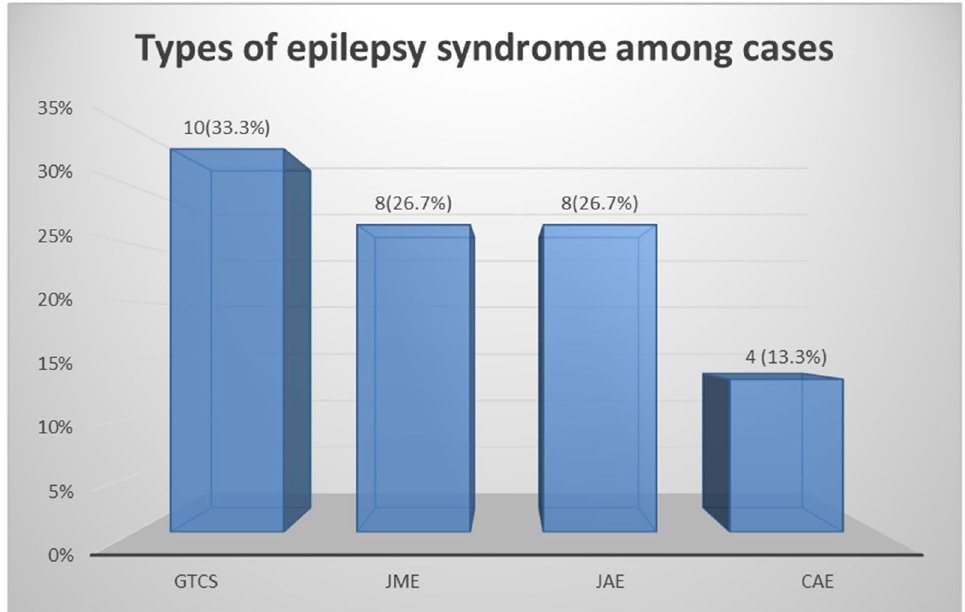
Fig. 1 The distribution of the epileptic syndromes among the epileptic patients. GTCA generalized tonic–clonic‑alone, JME Juvenile myoclonic epilepsy, JAE Juvenile absence epilepsy, CAE childhood absence